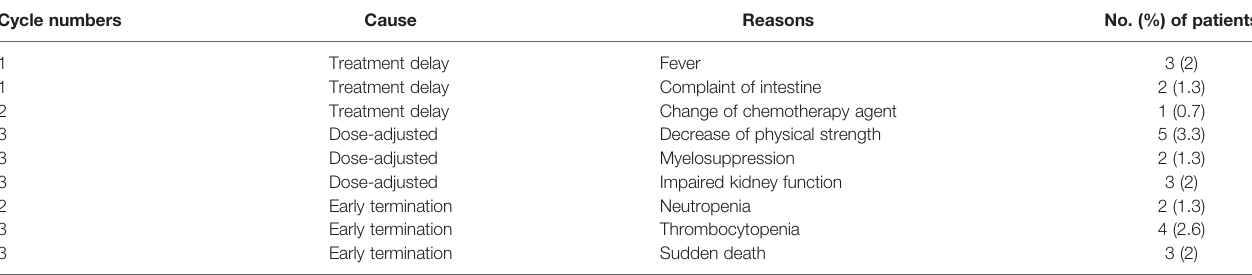
TABLE 3 | Delay, dose-adjusted, and early termination of chemotherapy(N =